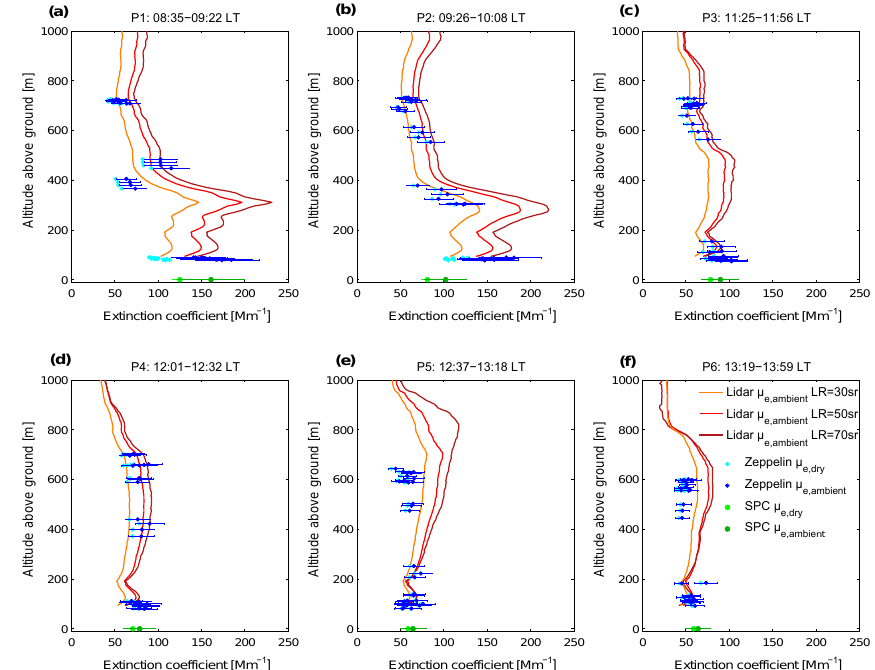
Figure 8. Extinction coefficients for profiles P 1– P 6 at different times of day. The lines reflect lidar results for assumed LRs of 30, 50 and 70sr in orange, red and dark red, respectively. The dots describe in situ results. In light and dark blue, dry and ambient airborne extinction coefficients are shown while the light and dark green dots represent the dry and ambient ground-based results,